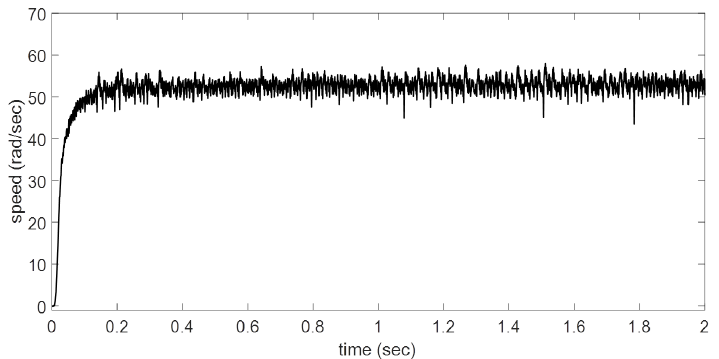
Figure 6. Rotor speed performance for reference tracking, case a .